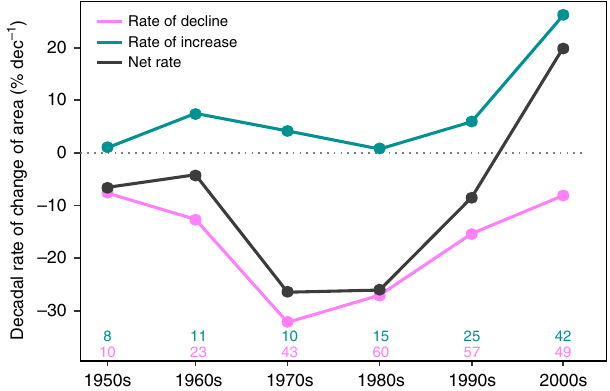
Fig. 3 Decadal rate of change of area of European seagrasses (1950s – 2000s). Decadal analysis includes time series >8 years. Number of sites per decade and trajectory are given at the bottom of the